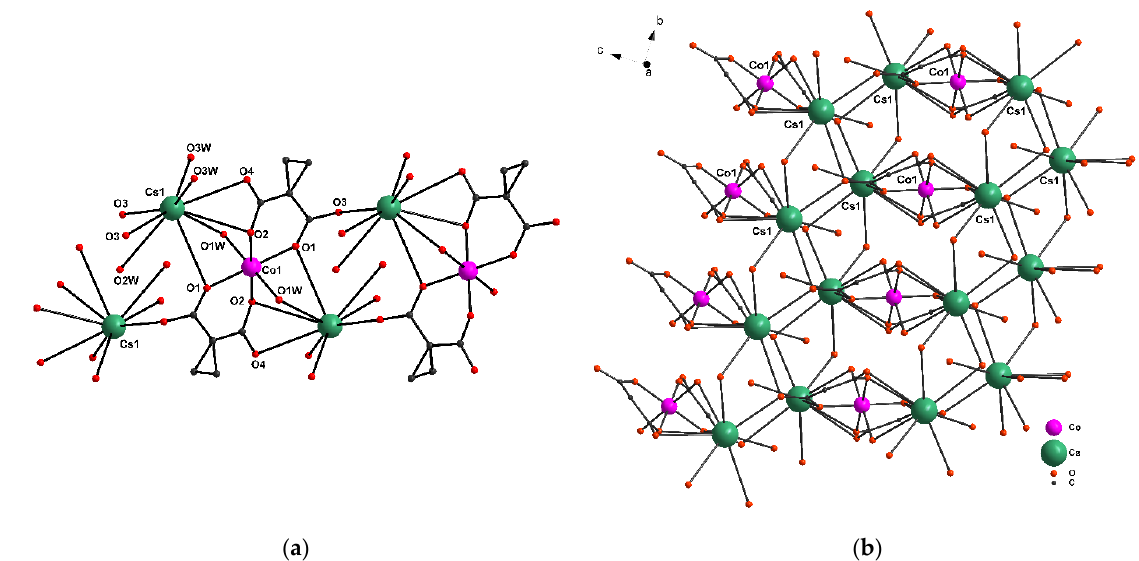
Figure 2. ( a ) A fragment of complex 2; ( b ) the layer fragment (hydrogen atoms and carbon sub- stituents in ( b ) are hidden for clarity).